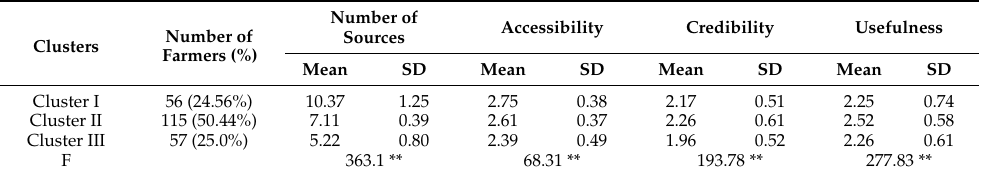
Table 4. Behavior of information-seeking clusters identified from cluster